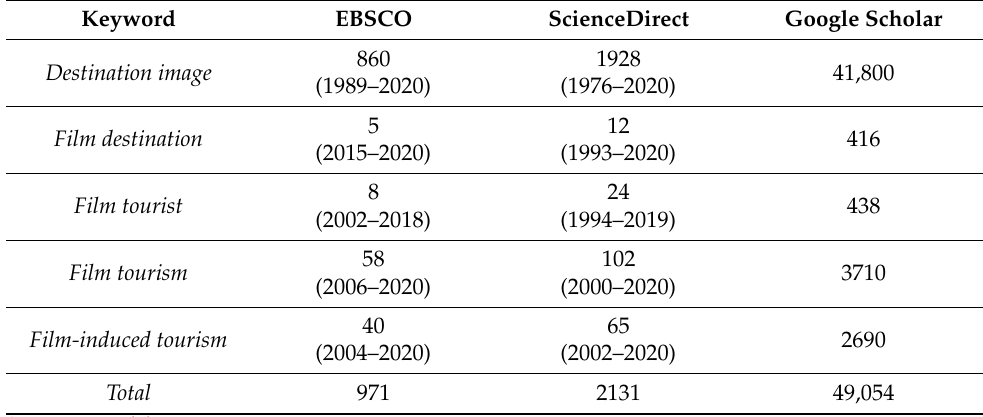
Table 2. Main keywords in the research literature and search results previous to the selection and exclusion